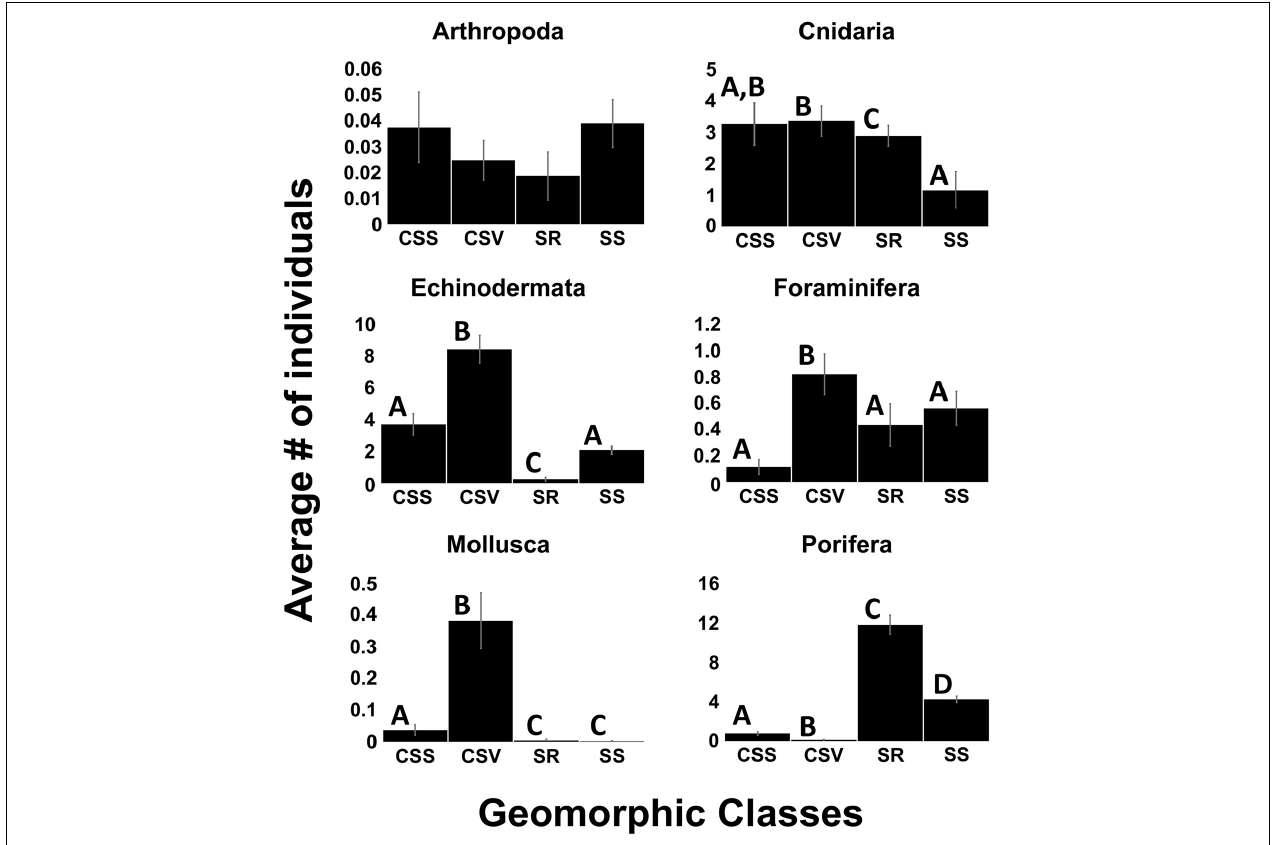
FIGURE 6 | Abundances of phyla as a function of geoformorphic classes Continental Slope Slope, Continental Slope Valley, Seamount Ridge, and Seamount Slope ( n = 1,105). Error bars are standard error. Different letters within phyla denote significant differences in abundances.